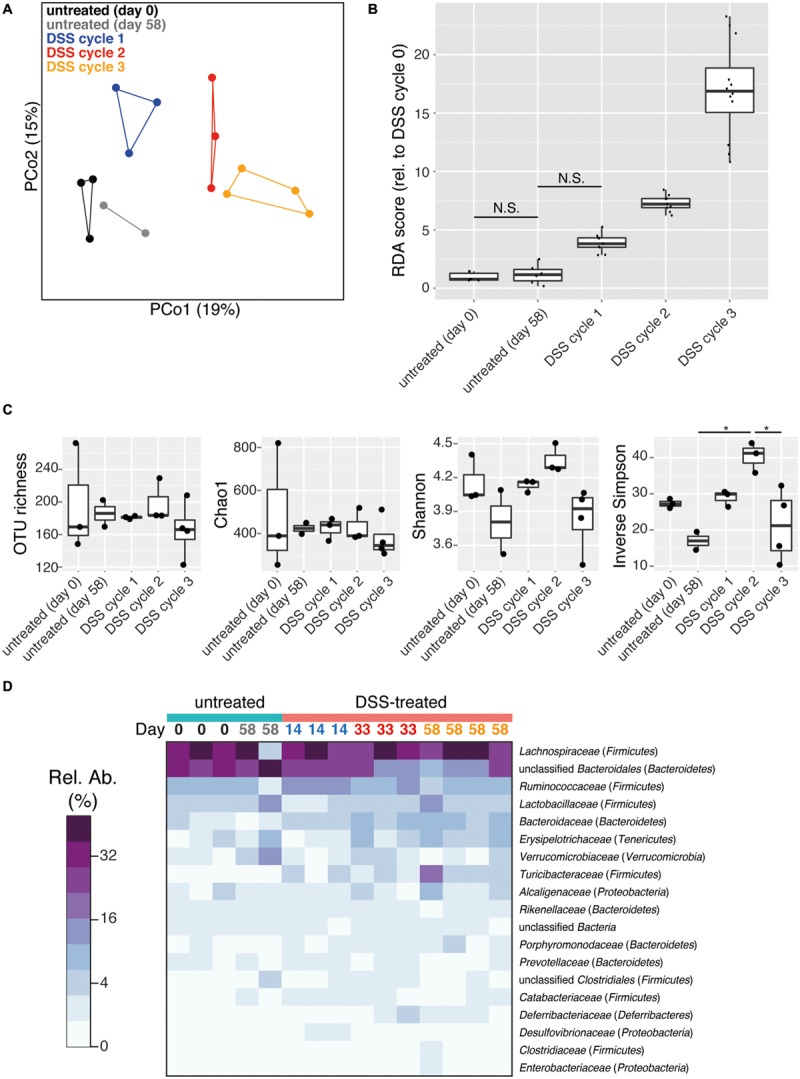
DSS treatment shapes recovery-phase intestinal microbiota composition and diversity. All data is from intestinal (cecum and colon) flush samples. (A) Principal coordinates analysis (PCoA) using the Bray–Curtis dissimilarity metric reveals clustering of samples based on number of DSS treatment cycles (points are connected by lines to illustrate clustering). This clustering is statistically supported by the ANOSIM test (R = 0.3379, p = 0.003). (B) Differences in microbiota composition relative to day 0 untreated samples based on redundancy analysis are shown. All pairwise comparisons between groups are significant (p < 0.05) except for those joined by a horizontal bar labeled N.S. (C) Estimation of microbial community richness (observed OTU richness and Chao1 estimated richness) and diversity (Shannon and inverse Simpson indices) for each sample. For all analyses sequence libraries were sub-sampled to 1000 reads. An asterisk indicates a significant difference between groups (ANOVA and Tukey’s HSD post hoc test, p < 0.05). (D) Heatmap of the relative abundance of family-level taxa (rows) for each sample (columns). The abundance is shown in relative percent and the scale is square root transformed to allow visualization of less abundant groups. Families with at least 1% relative abundance in at least one sample are shown. Columns are labeled with sample day and color-coded by DSS cycle (1 = blue, 2 = red, 3 = orange).